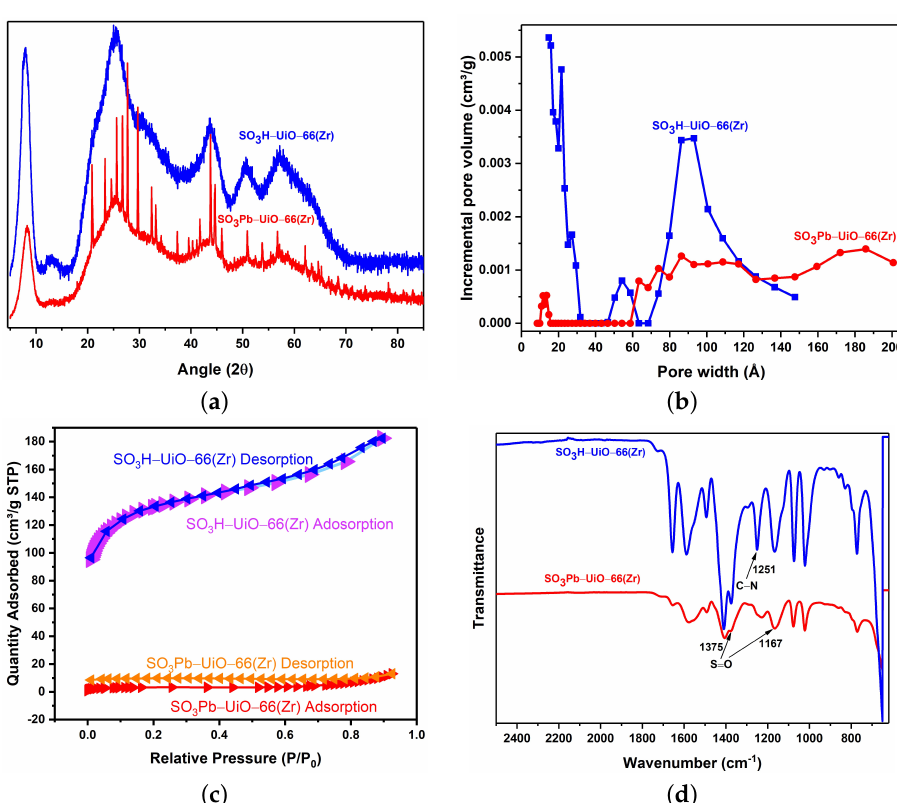
Figure 1. ( a ) XRD curves, ( b ) Pore size distribution, ( c ) N 2 adsorption/desorption isotherms, and ( d ) FT-IR spectra of SO 3 H-UiO-66(Zr) and SO 3 Pb-UiO-66(Zr)